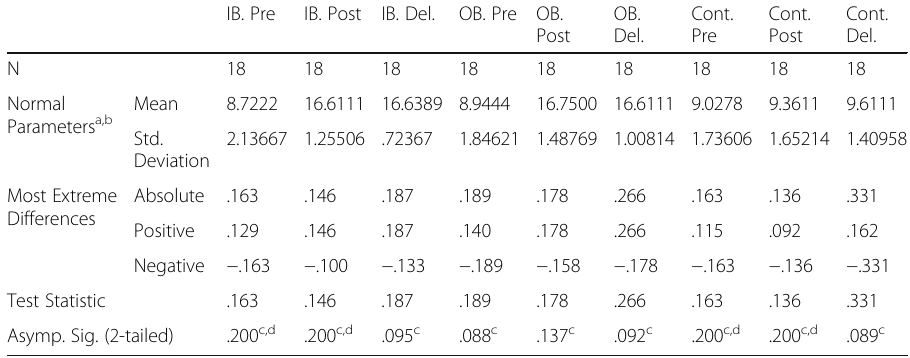
Table 1 One-Sample Kolmogorov-Smirnov Test (Groups ’ Pre-test, Post-test, and Delayed post-tests) IB. Pre IB. Post IB. Del. OB. Pre OB.